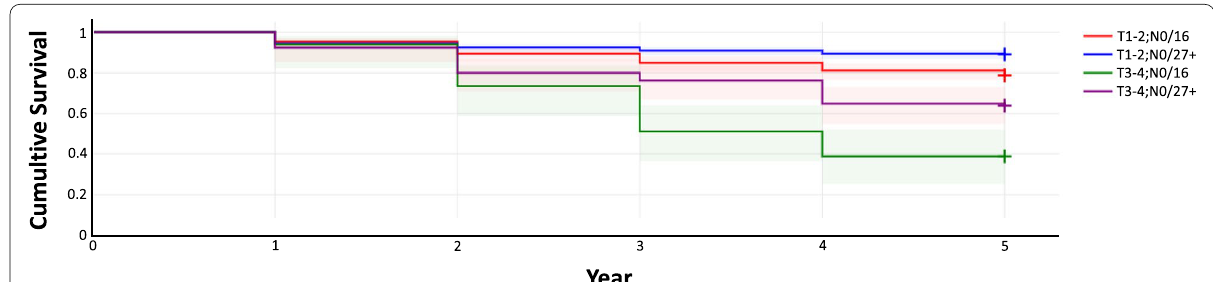
Fig. 4 Relative cumulative survival in nodal negative patients with different lymph node count. Survival function and confidence intervals for T1/2 and T3/4 nodal negative patients with exactly 16 or 27 or more harvested and evaluated